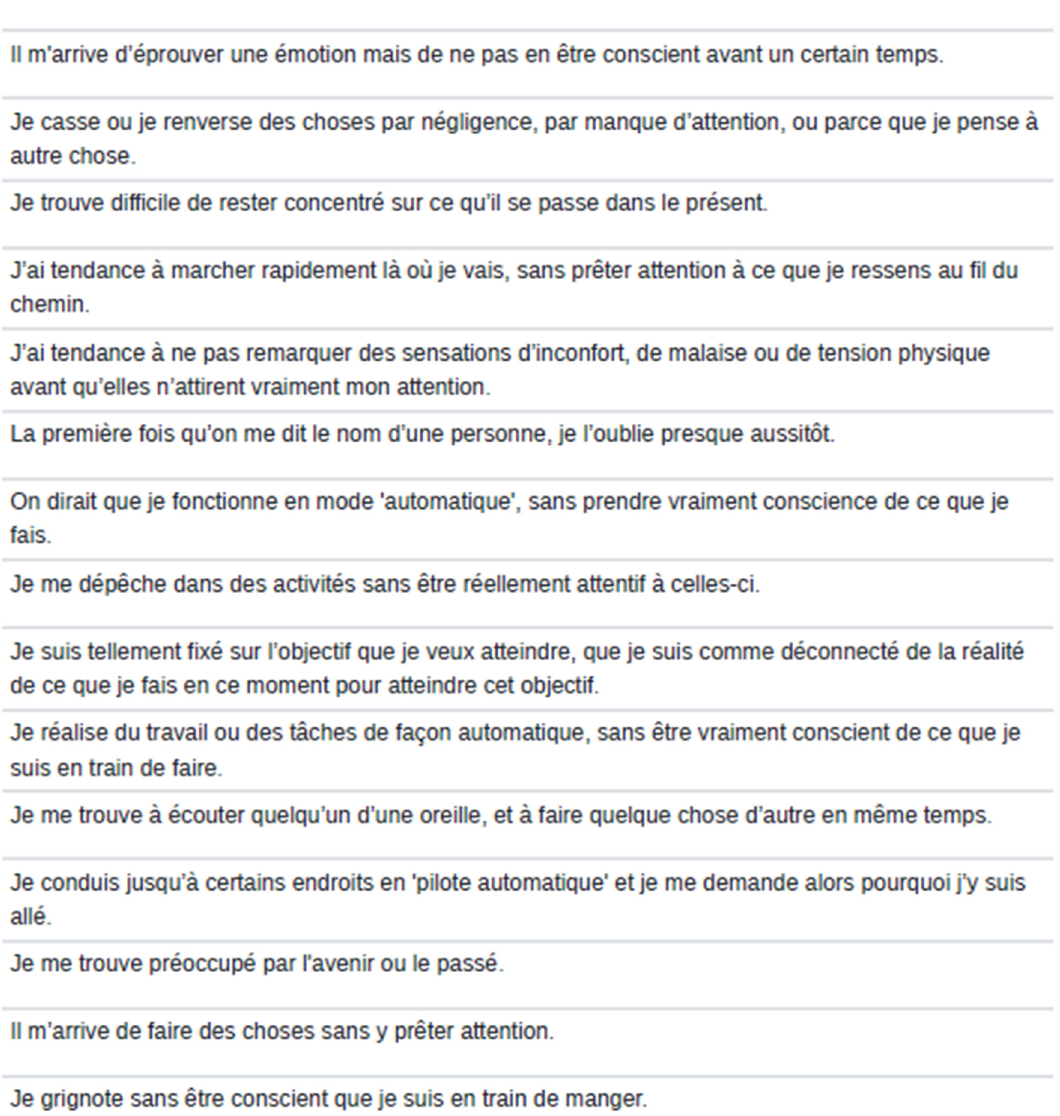
Figure A2. The translated version of the Mindful Attention Awareness Scale (MAAS).